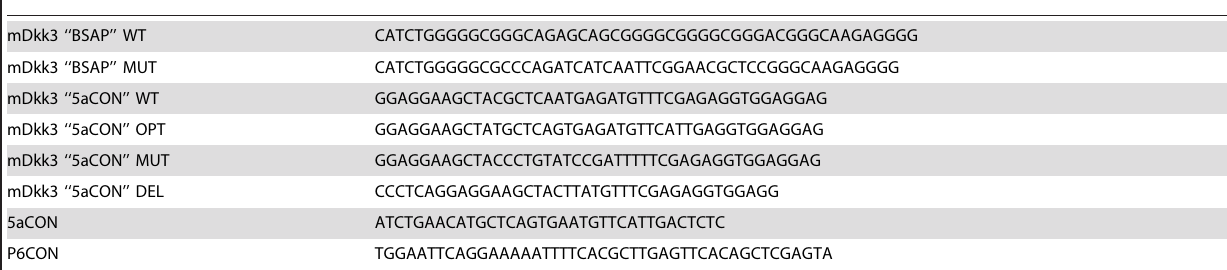
Table 3. Oligonucleotides used in EMSA and in vitro mutagenesis.